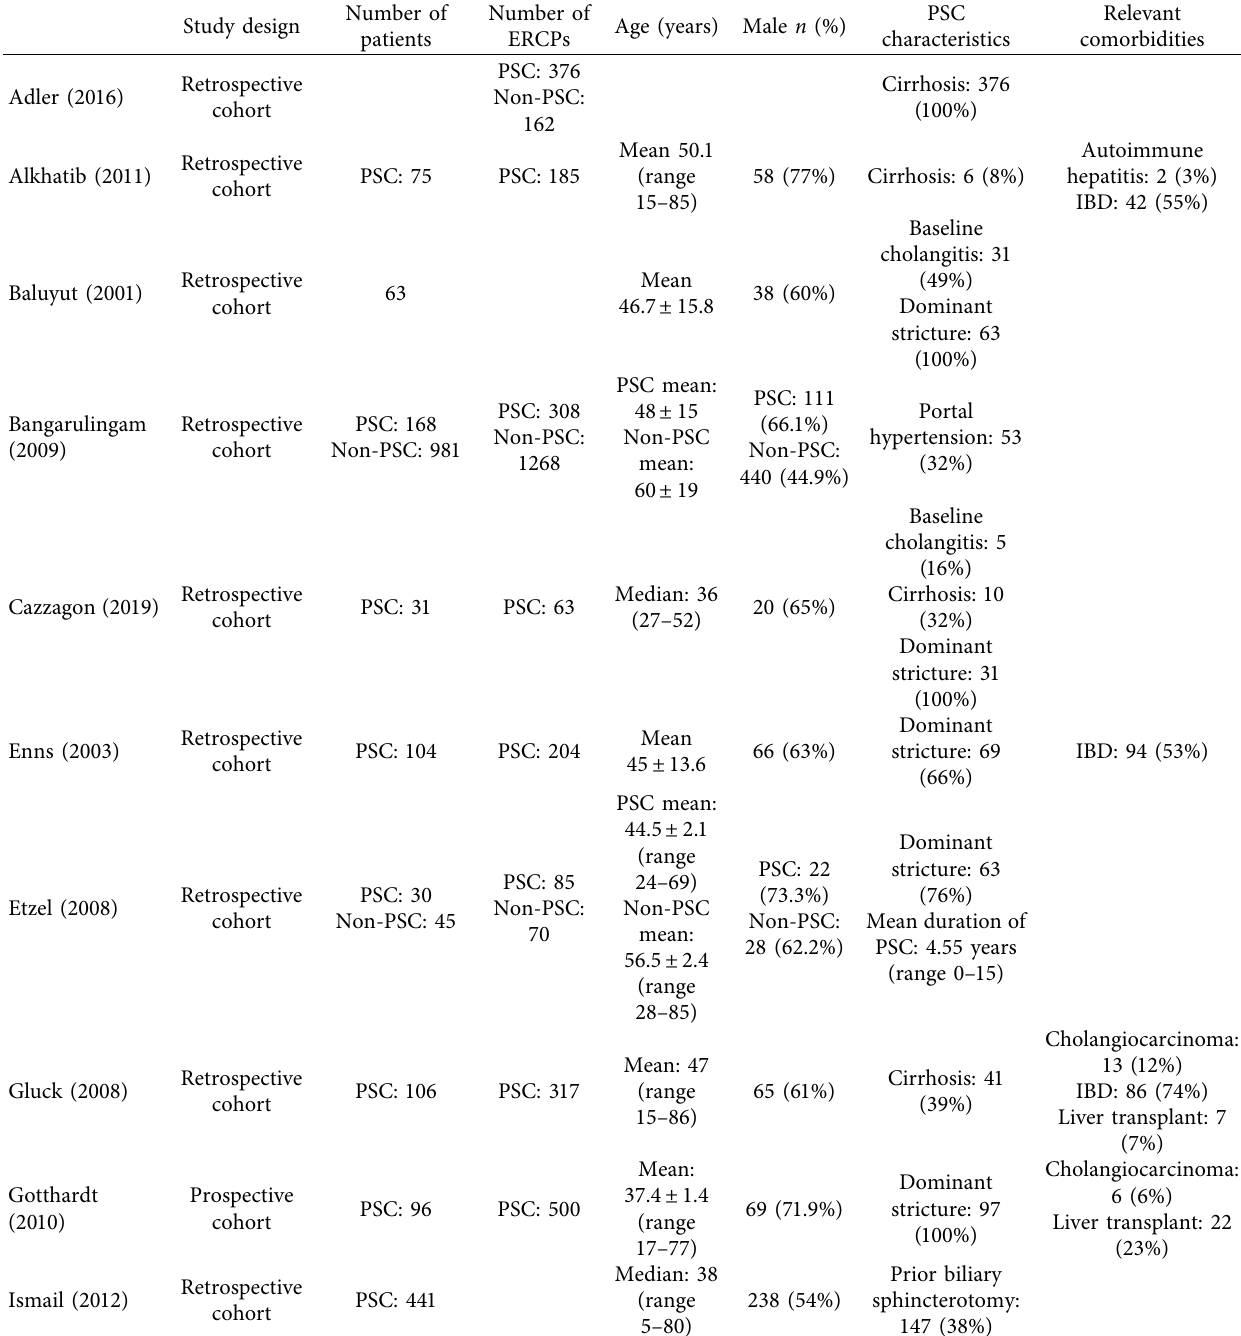
Table 2: Characteristics of included studies and